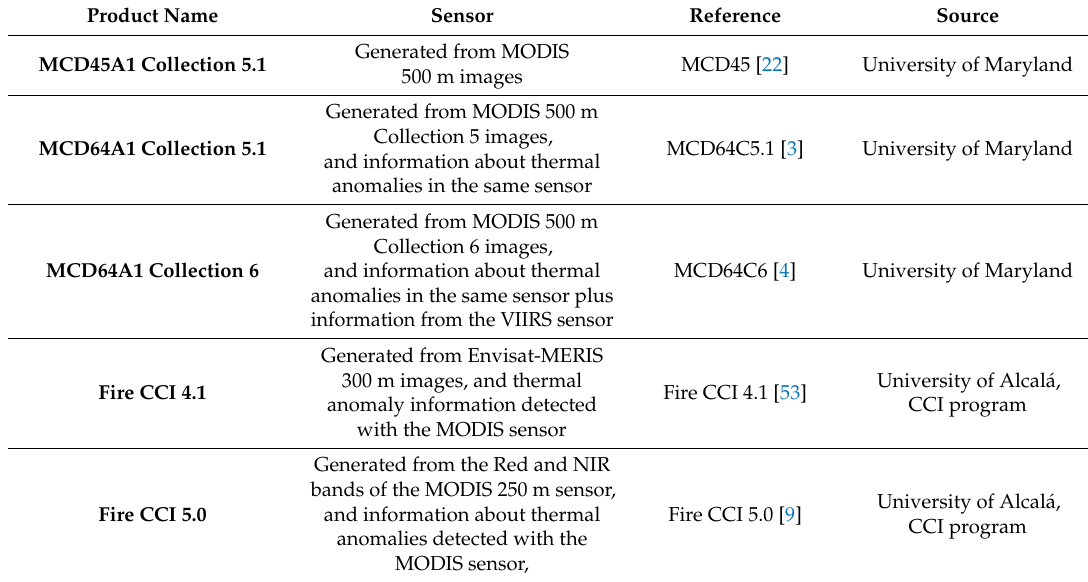
Table 1. List of BA products analyzed in this